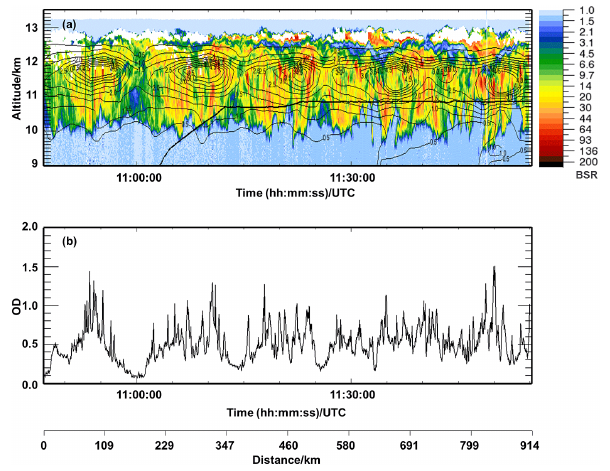
Figure 3. (a) Backscatter ratio at 532nm (colour shading) between 10:47 and 11:54UTC on 4 November 2010. White areas are caused by saturation of the detection optics. The thick black solid line indi- cates the altitude of the DLR Falcon; the black contour lines show the ECMWF cloud ice water content of 0.5–4.5mgkg − 1 . (b) Opti- cal depth (OD) at 532nm of the cirrus cloud derived from WALES measurements.